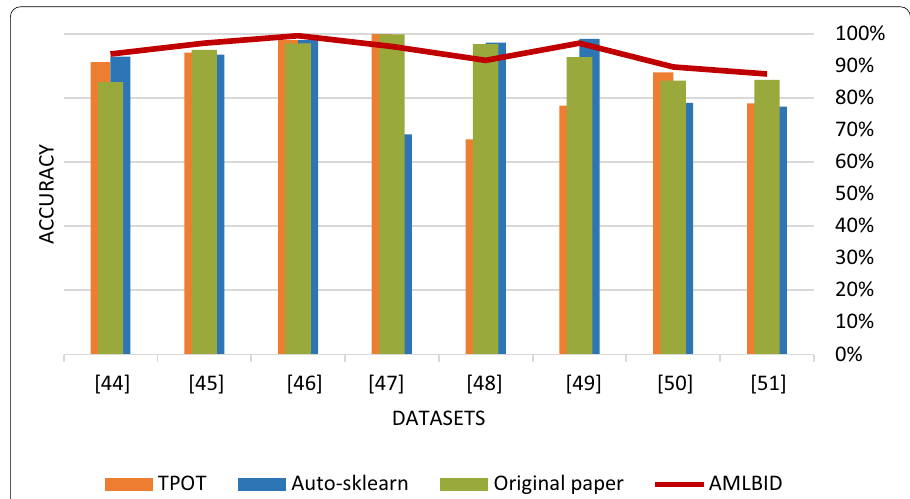
Fig. 2 The cumulative gains chart of AMLBID and the baseline AutoML tools over the state-of-the-art datasets